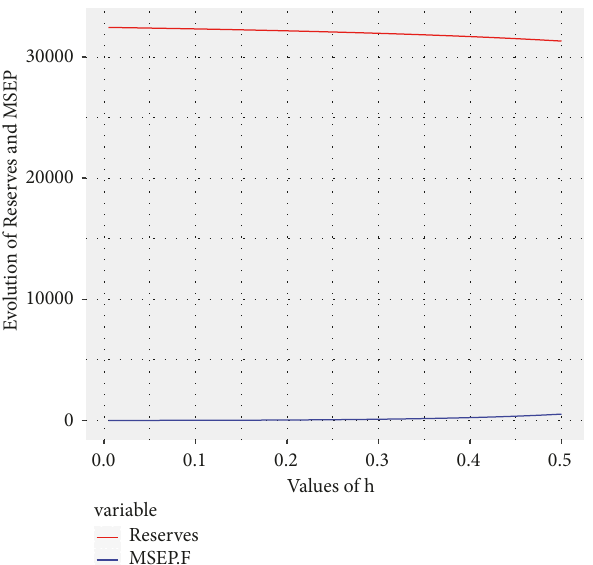
Figure 3: Evolution of reserves and MSEP with respect to ℎ− values (data of Table 2).